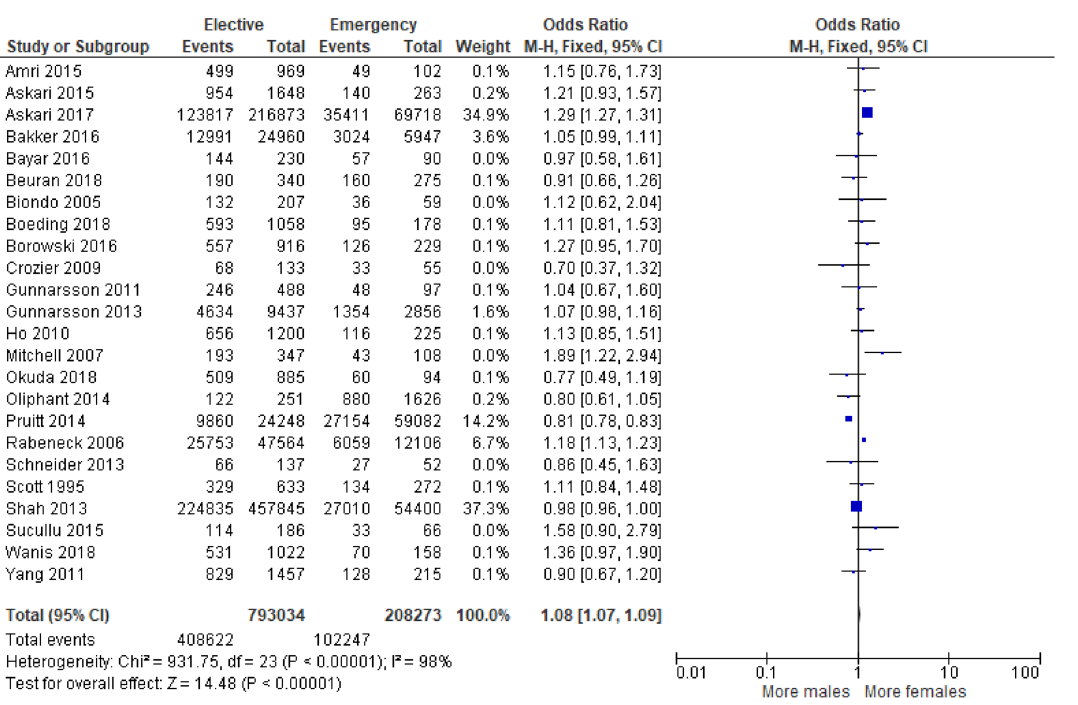
Figure 12. Association between sex and emergency presentation—Forest